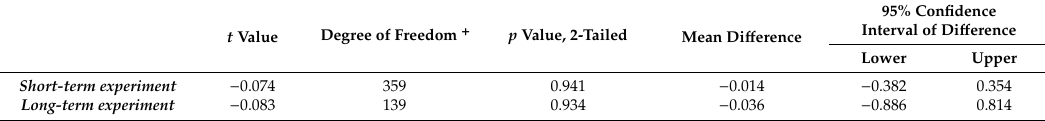
Table 3. Results of one sample t -test in short-term and long-term experiment.